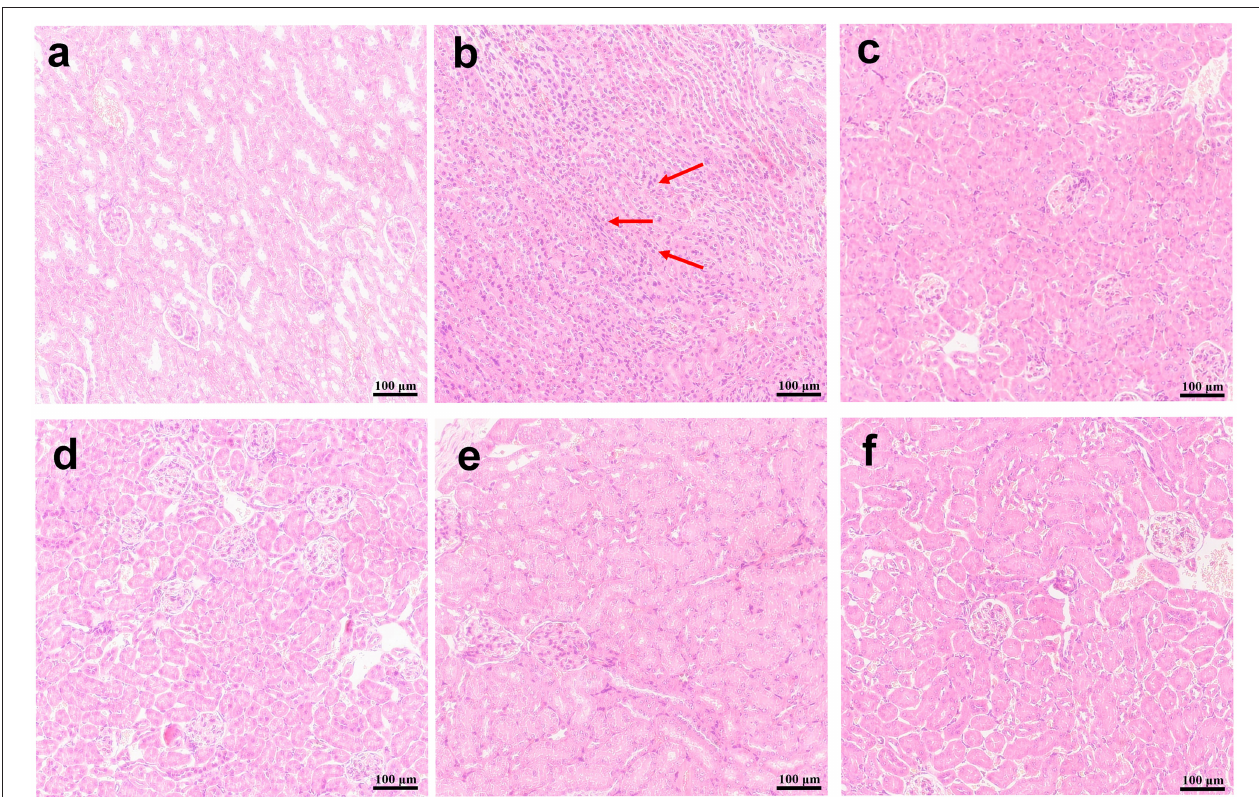
FIGURE 9 | Kidney histopathology. H&E stain representations are provided for (A) the kidney of normal mice; (B) infections with C. albicans alone, or (C) treatments with 1.5 mg/kg/d of FLC, (D) 0.5 mg/kg/d of SAN, (E) 1.5 mg/kg/d of SAN, and (F) 2.5 mg/kg/d of SAN. Dark blue staining reflects areas of acute inflammation. Magnifications, ×